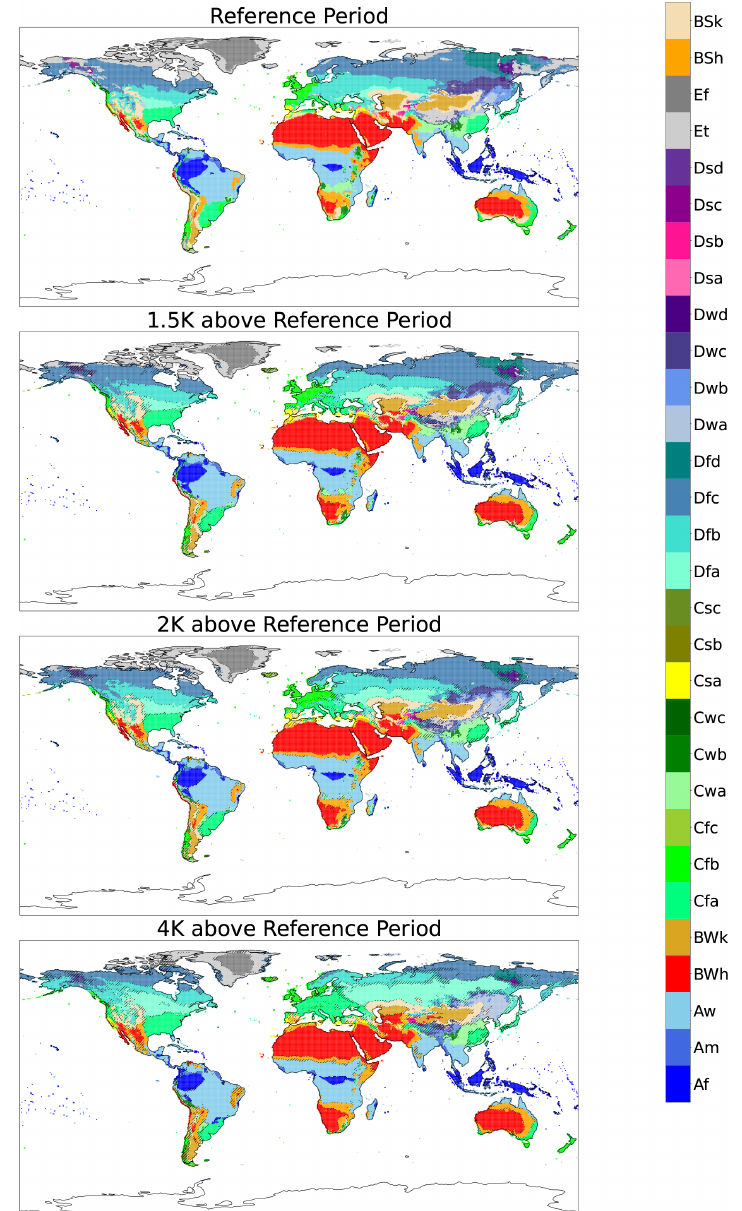
Figure 3. Maps of the original KG classifications calculated from the multi-model ensemble mean for the reference period and 1.5, 2.0, and 4.0K of global warming relative to the reference period. These were calculated from the SSP585 runs by anomaly correction relative to the observed reference climate. Hatching is present when less than 66% of models agree on a region’s classification.